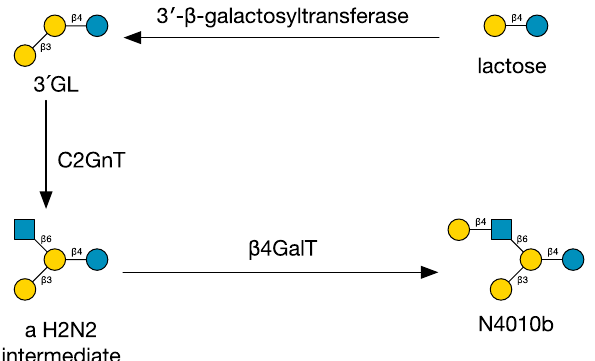
Figure 10. Proposed biosynthetic pathway of lacto- N -novopentaose I